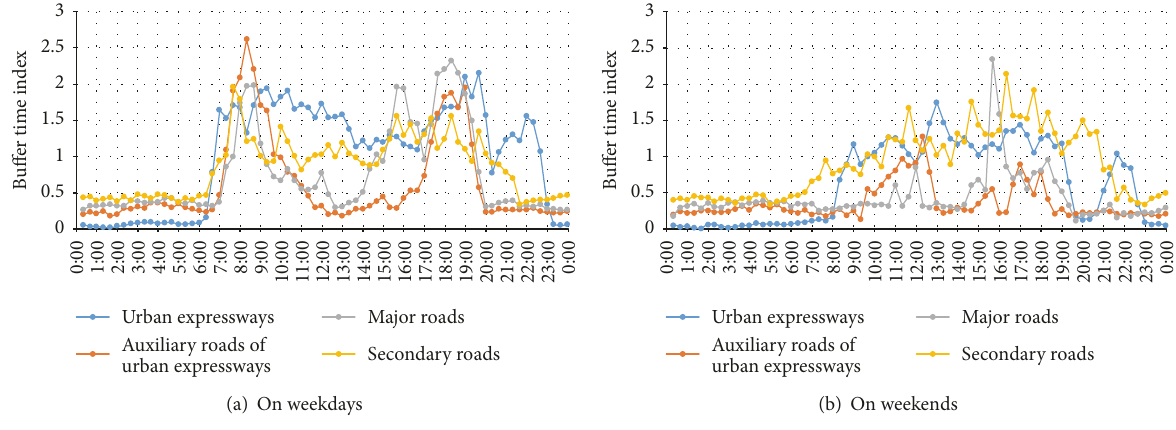
Figure 4: Buffer time index through the